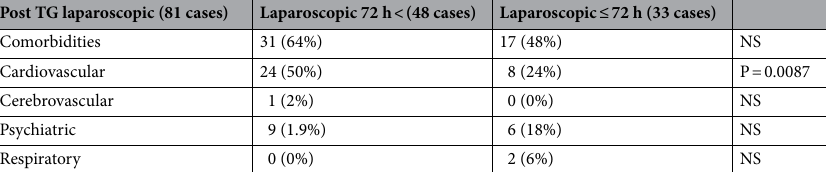
Table 5. Laparoscopic cholecystectomy and comorbidities. There are many cases with cardiovascular disease in delayed group, the prevalence had reached 50% as compared with early group of 24% (P =0.0087).